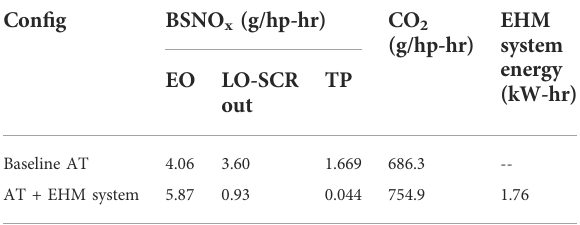
TABLE 7 Beverage Cycle test